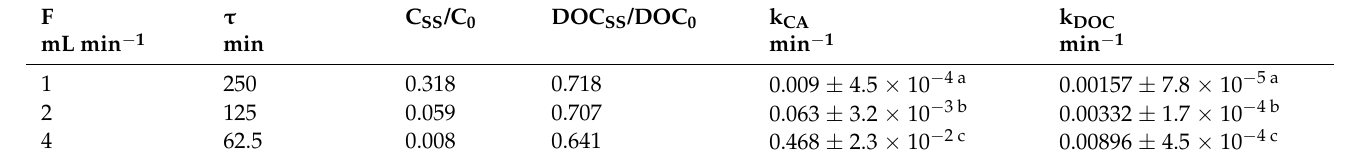
Table 3. Kinetic constants from CA and DOC removal observed for the assays with different flow rates (mL min − 1 ). Means in the same column with different letters represent significant differences ( p < 0.05) within each parameter (k CA and k DOC ) by comparing flow rates.